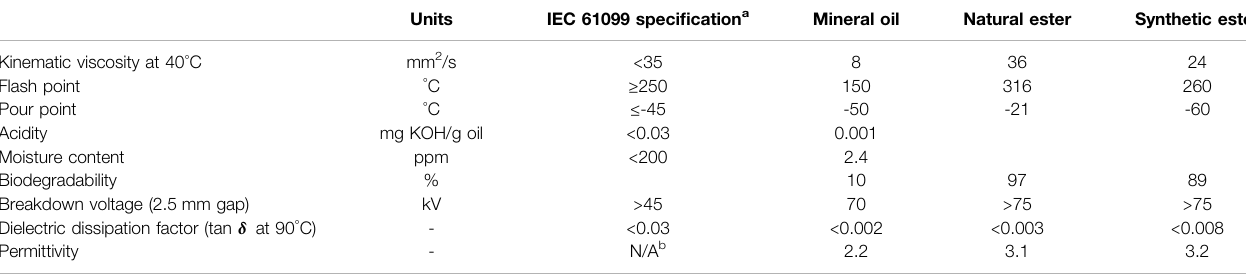
TABLE 7 | Basic physicochemical and dielectric properties of mineral oil, natural ester, and synthetic